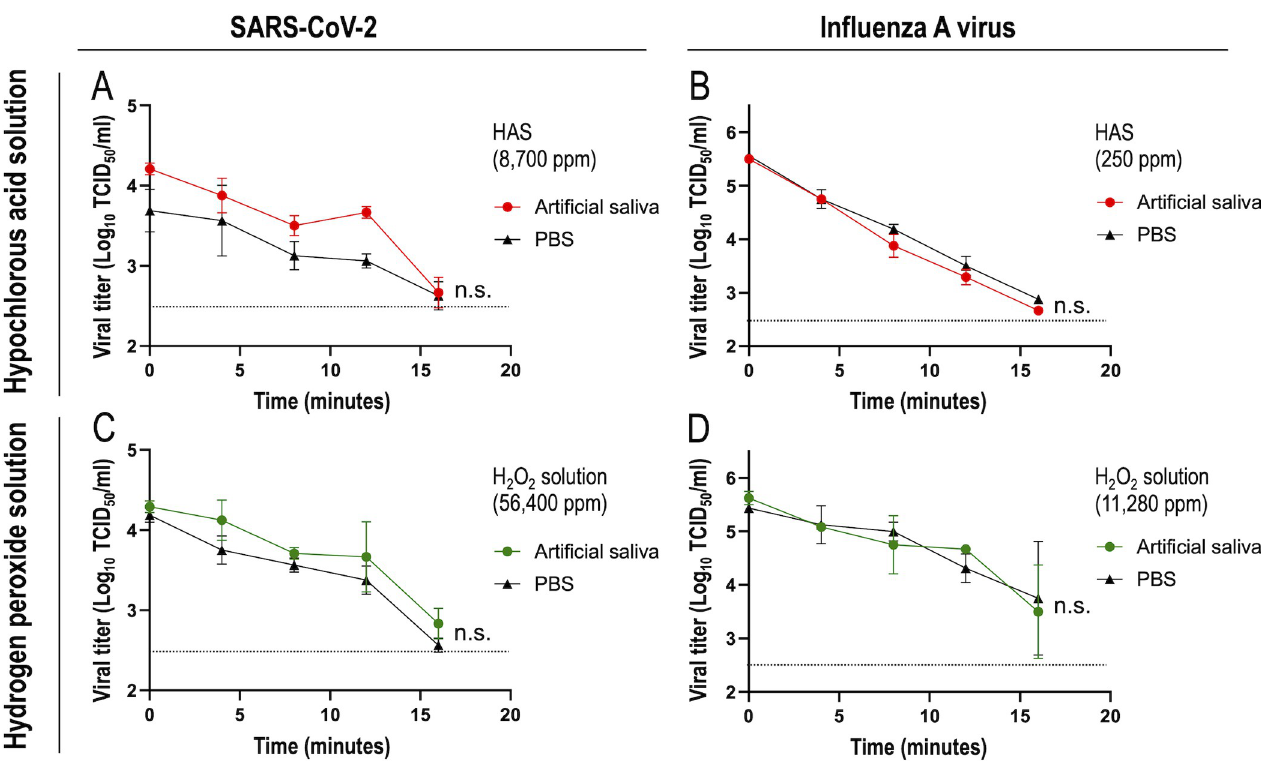
Fig 6. Effects of saliva on the inactivation of SARS-CoV-2 and influenza A virus by the dry fogging of disinfectants. SARS-CoV-2 (A and C) or influenza A virus (B and D) was mixed with artificial saliva or PBS, and air-dried. Changes in the viral infectious titers (TCID 50 values) upon dry fogging with hypochlorous acid solution (HAS) (A and B) or hydrogen peroxide solution were then evaluated, as described in the Materials and methods. Horizontal dotted lines in the graphs show the detection limit of the viral titer. n.s., not significant between artificial saliva- and PBS-containing samples using an unpaired t -test. Each data point represents the average and standard deviation obtained from two repeated